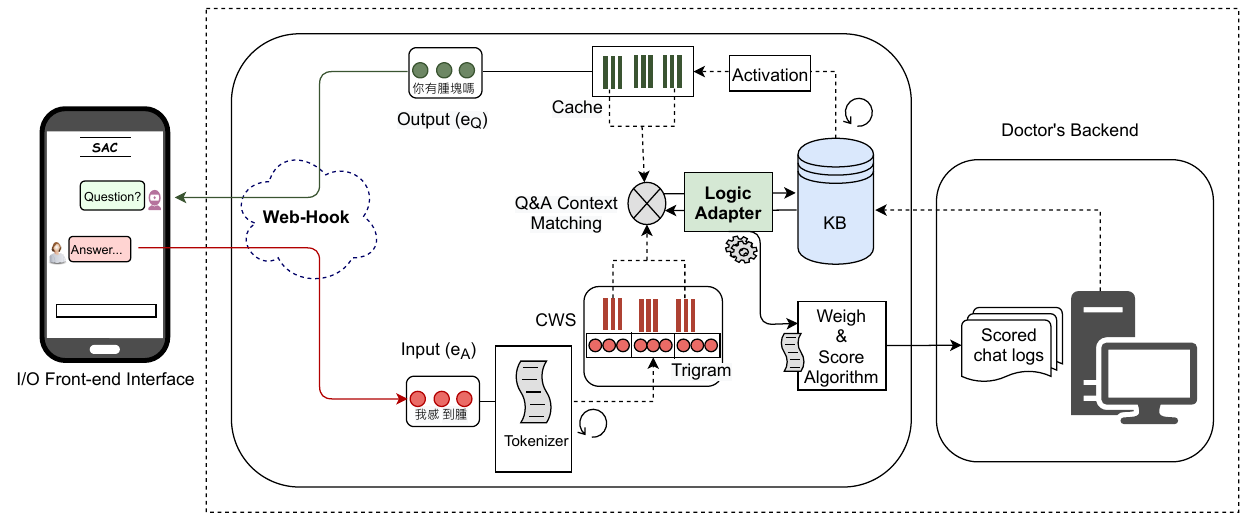
Figure 6. An overview of the SAC dialog system architecture. Herein, e A represents the user’s input answer embedding, whereas e Q represents the agent’s output question